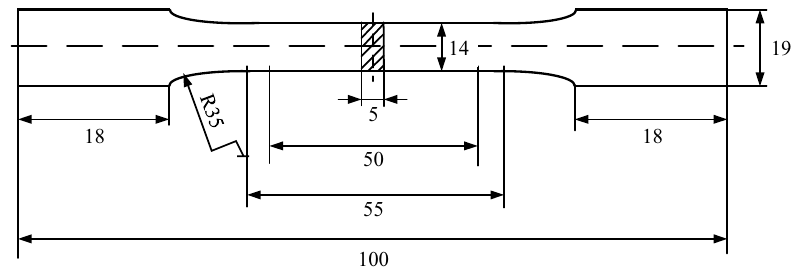
Figure 2: Tensile specimens with mechanical properties.